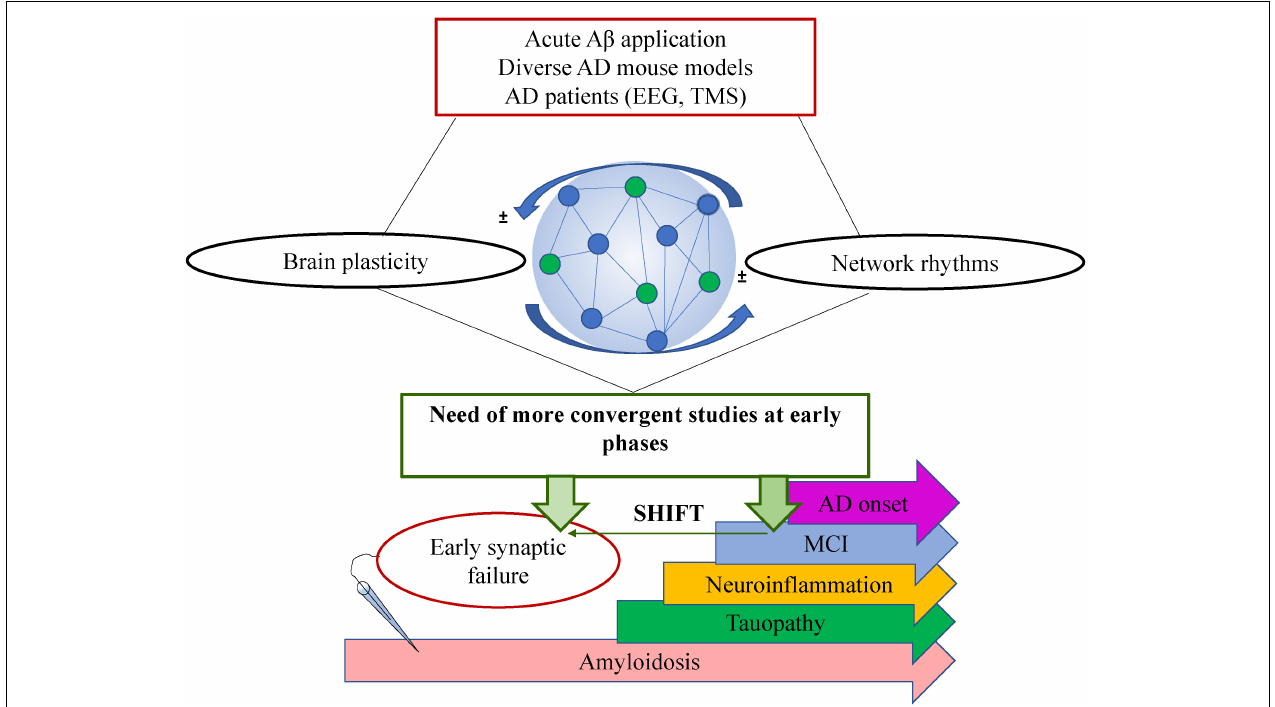
FIGURE 1 | Schematic showing the complexity of AD research with regards to brain plasticity and neuronal network rhythms. A general summary of the type of studies is shown on top (red box), the bidirectional interplay between plasticity and oscillations within the neuronal network is shown in the middle where a very simplified schematic of a neuronal network is shown formed by connected pyramidal cells (blue circles) and interneurons (green circles). The future perspective is shown in the green box claiming a shift of the studies toward earlier time points (green horizontal arrow). On the bottom, there is a schematic timeline showing the most prominent pathological events that takes place during AD progression where electrophysiological recordings at earlier stages have revealed very early synaptic failure on the neuronal circuit’s performance. MCI: Mild cognitive impairment.